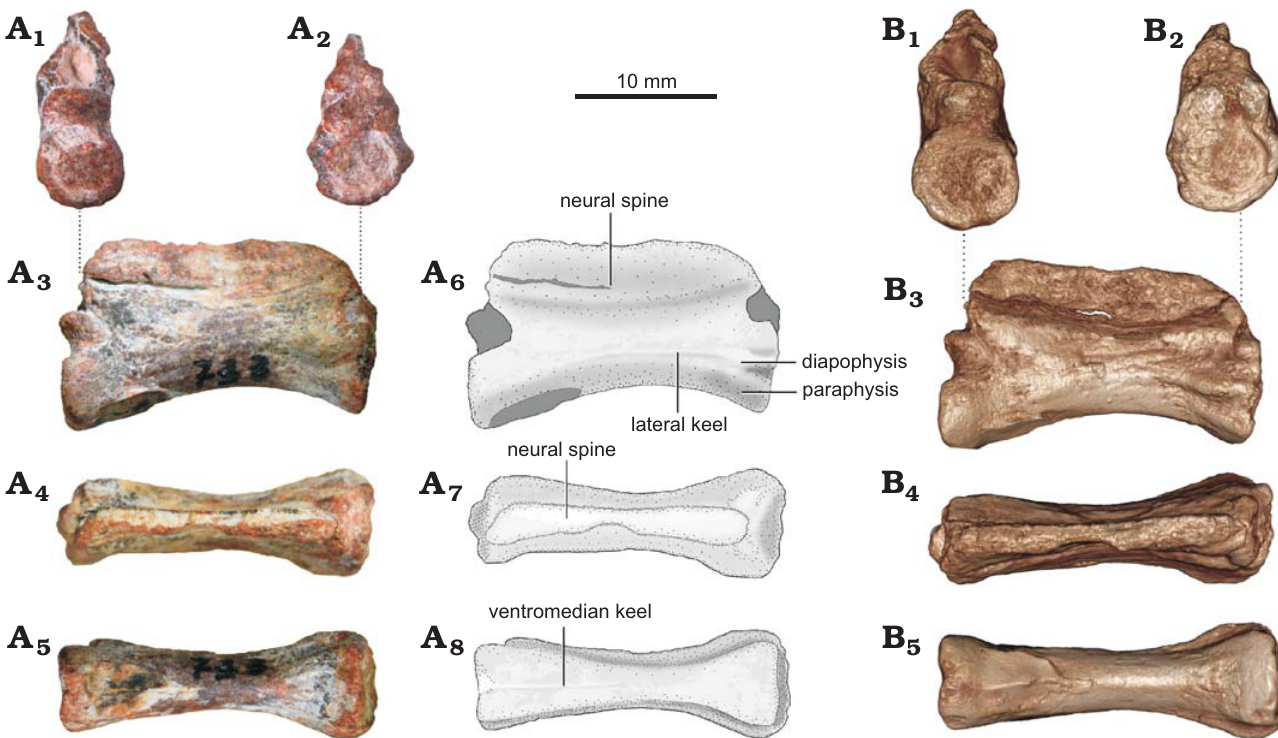
Fig. 1. Cervical vertebra (UNIPAMPA 733) of ?Tanystropheidae indet. from Sanga do Cabral Formation (Induan–early Olenekian). A . Photographs (A 1 –A 5 ) and explanatory drawings (A 6 –A 8 ). B . Virtual 3D reconstructions (see SOM 2). In posterior (A 1 , B 1 ), anterior (A 2 , B 2 ), right lateral (A 3 , A 6 , B 3 ), dorsal (A 4 , A 7 , B 4 ), and ventral (A 5 , A 8 , B 5 )